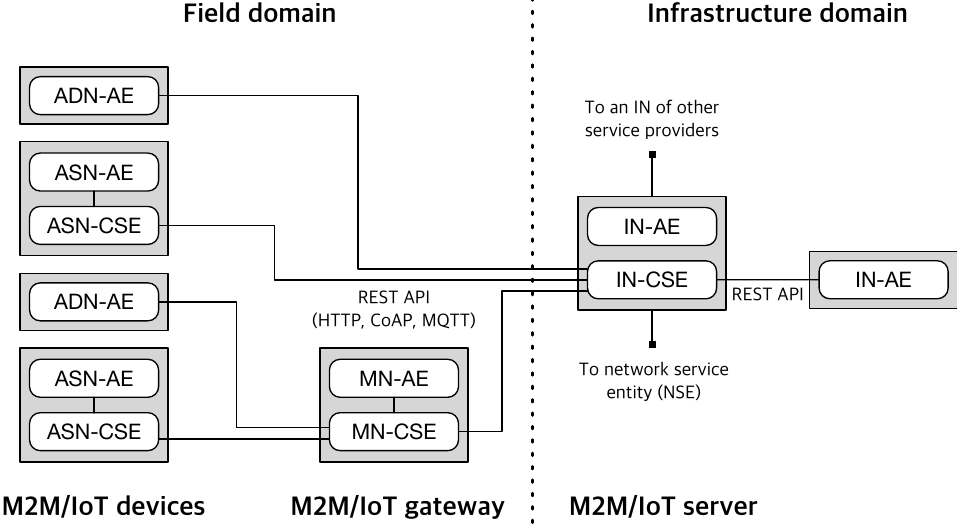
Figure 2. oneM2M reference